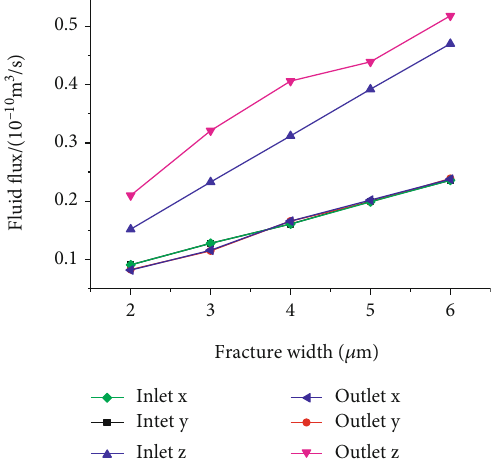
Figure 7: Curve of equivalent permeability with di ff erent fracture